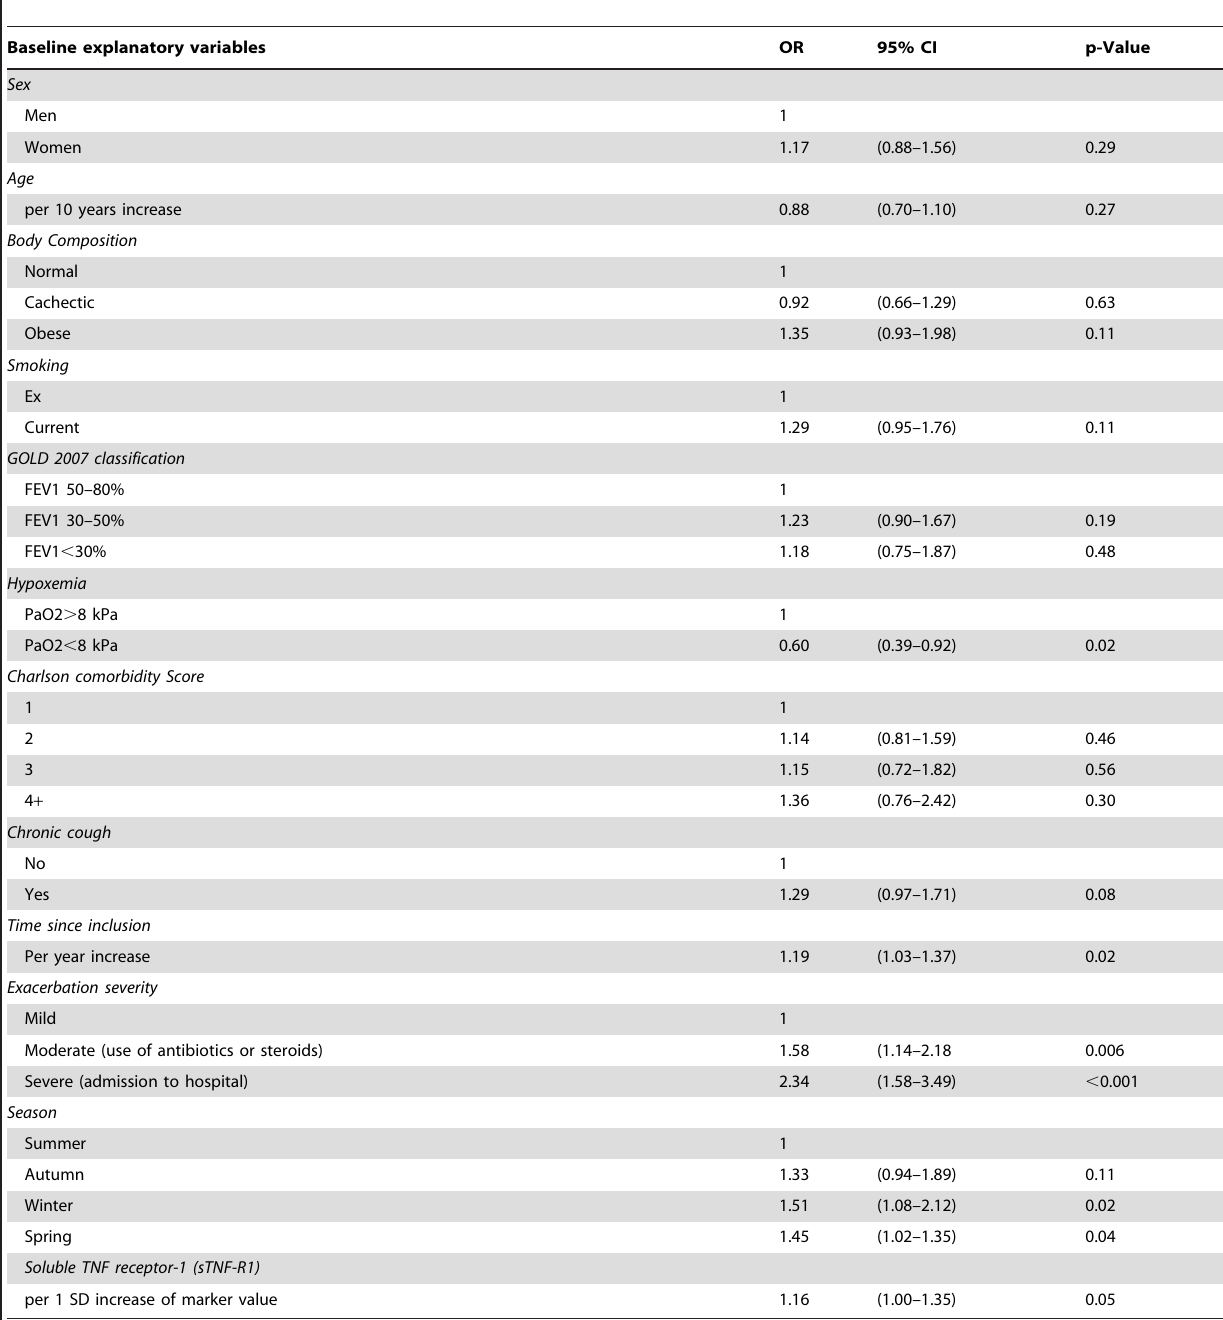
Table 5. Multivariate model of copd-exacerbation duration more than three weeks, estimated by a generalized estimation equation logistic regression